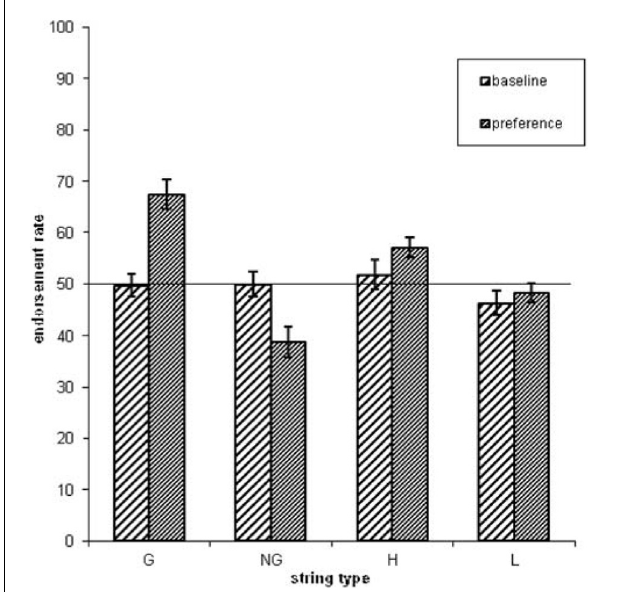
FIGURE 3 | The endorsement rates as a function of grammaticality status and associative chunk strength (G = grammatical, NG = non-grammatical, H = high ACS, L = low ACS sequences). Error bars correspond to standard error of the mean.